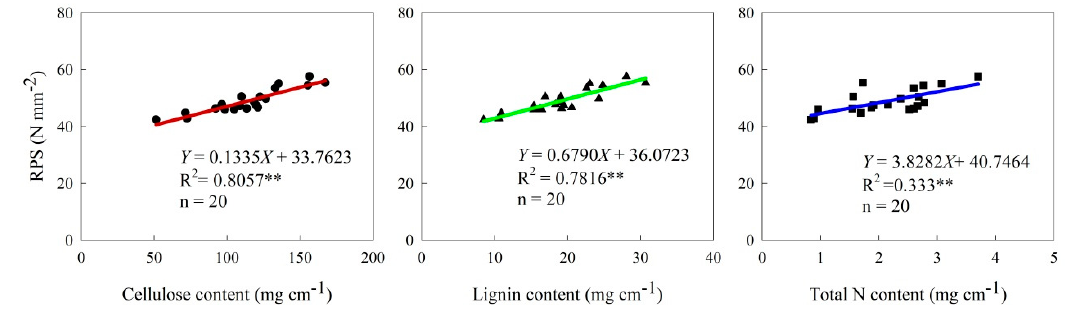
Figure 7. Relationships between the rind penetration strength (RPS) and the cellulose, lignin, and total nitrogen contents of the third internode of maize under drip irrigation.